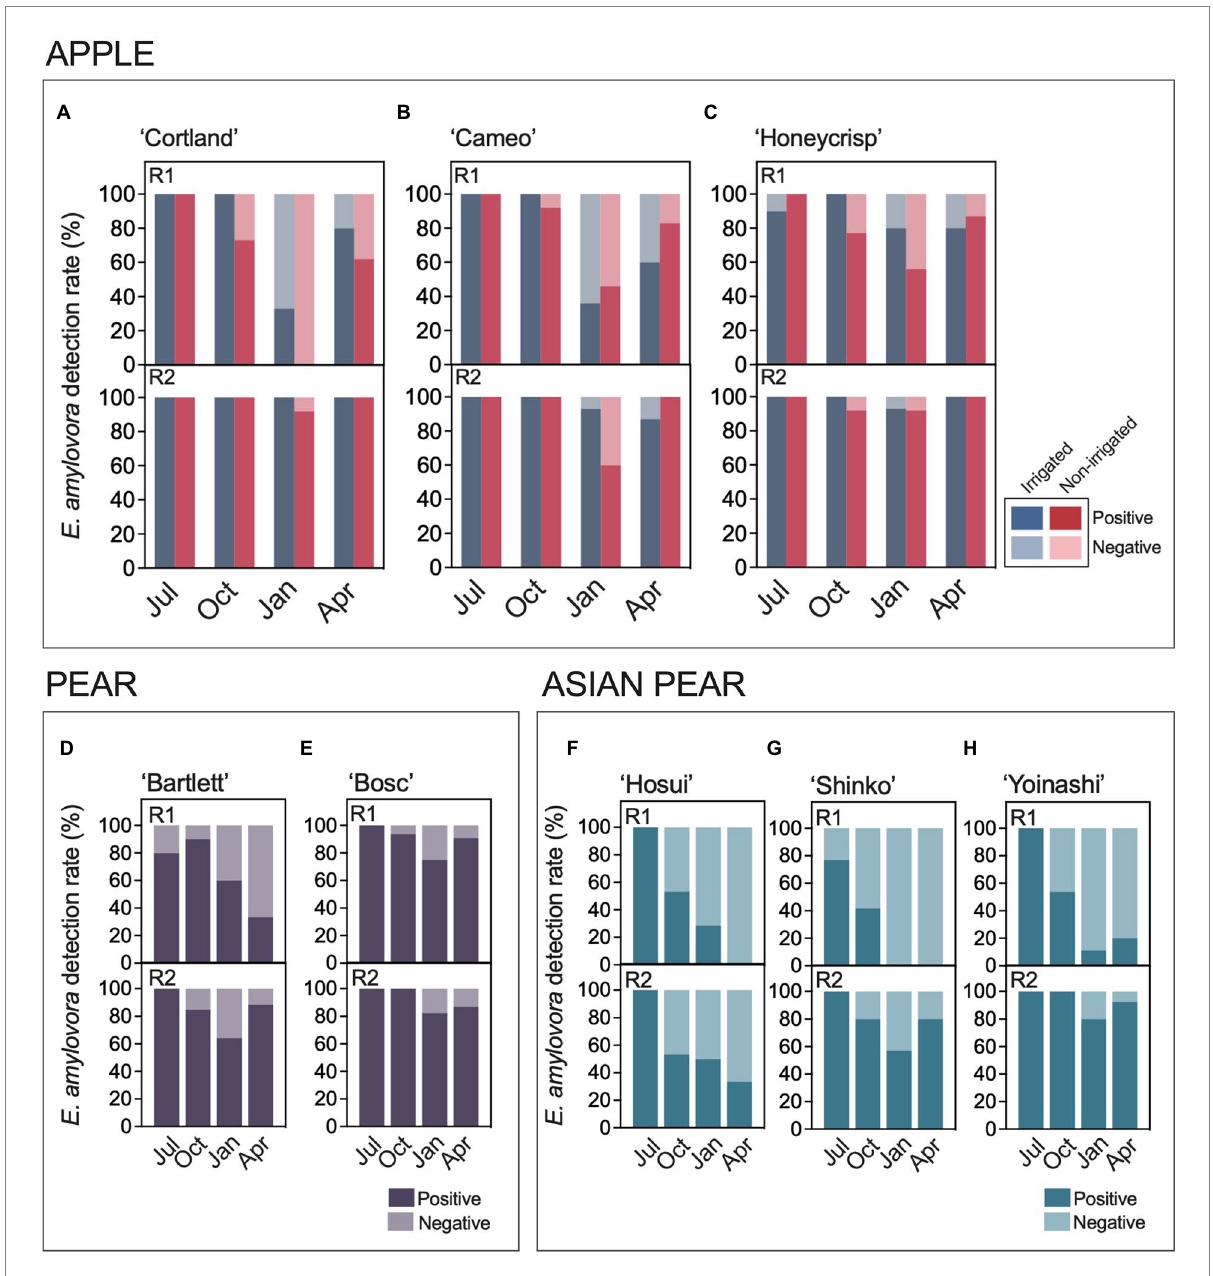
FIGURE 2 E. amylovora detection rates in cankers from irrigated and non-irrigated apple trees of cultivars ‘Cortland’ (A) , ‘Cameo’ (B) , and ‘Honeycrisp’ (C) , non-irrigated pear trees ‘Bartlett’ (D) and ‘Bosc’ (E) , and non-irrigated Asian pear trees ‘Hosui’ (F) , ‘Shinko’ (G) and ‘Yoinashi’ (H) . For each host species and cultivar, there are two graphs showing results from the experimental repeats R1, performed in 2016–2017 in Highland, NY; and R2, carried out in 2018–2019 in Highland, NY with apple, and in 2017–2018 in Belchertown, MA with pear and Asian pear. Sampling points: Jul,